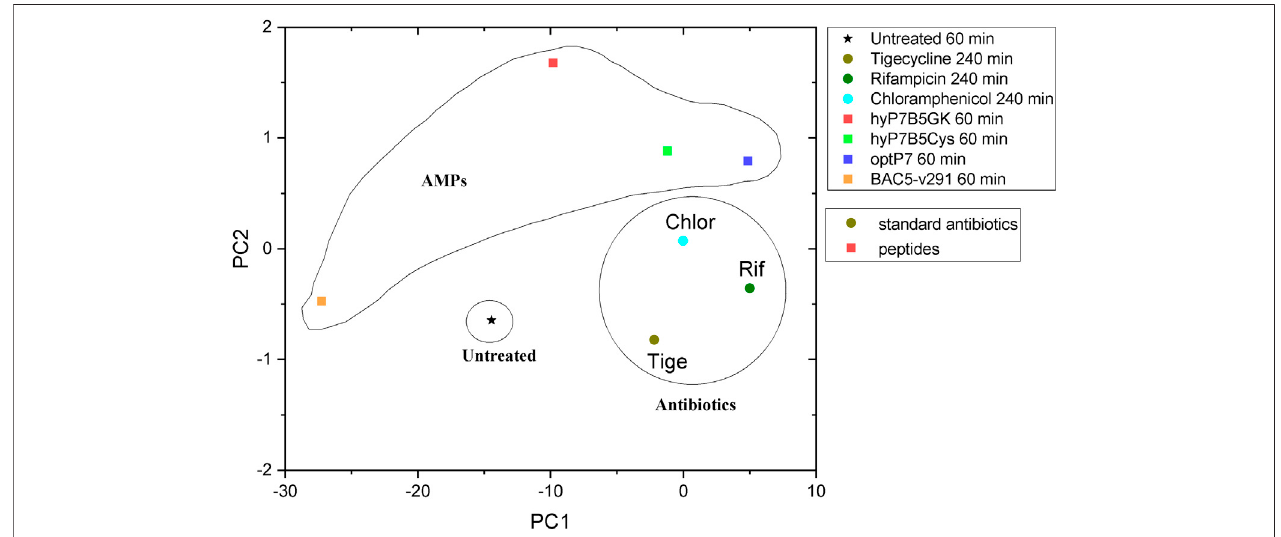
FIGURE 5 | Comparison between principal component analysis (PCA) of the BioSAXS curves of E. coli treated with different AMPs and antibiotics.